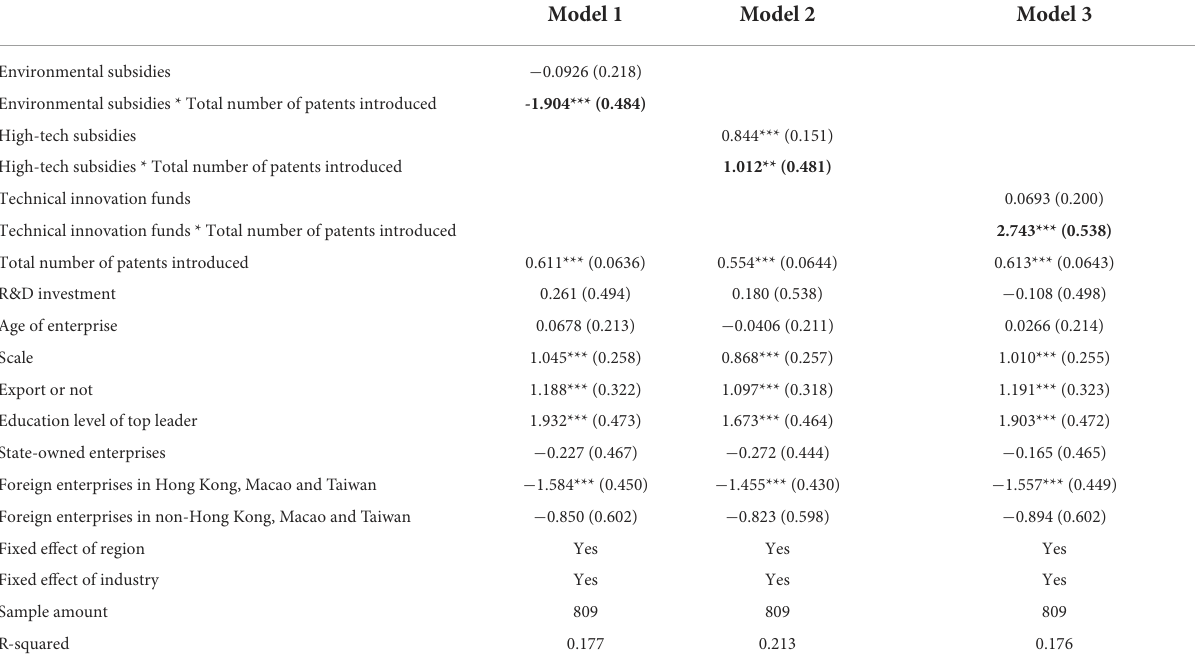
TABLE 5 Government subsidies and enterprises “imitative innovation.” Names of